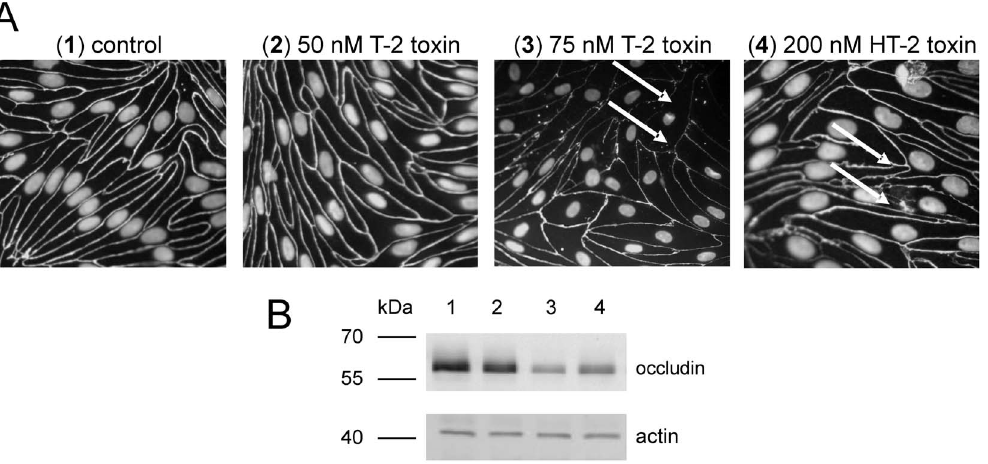
Figure 5. Immunocytochemical staining of occludin after T-2 and HT-2 toxin incubation from the apical side . A: Immunocytochemical staining of tight junction protein occludin in PBCEC after T-2 or HT-2 toxin incubation for 48 h from the apical side. TEER of control (A, 1) and 50 nM T-2 toxin (A, 2) incubated cells . 1000 V *cm 2 ; TEER of 75 nM T-2 toxin (A, 3) incubated filters . 50 V *cm 2 ; TEER of 200 nM HT-2 toxin (A, 4) incubated filters . 600 V *cm 2 . Regions of lost or impaired occludin are indicated by arrows. B: Western blotting of occludin with actin as loading control of control filters (B, 1), 50 nM T-2 toxin (B, 2), 75 nM T-2 toxin (B, 3) and 200 nM HT-2 toxin (B, 4) incubated PBCEC for 24 h.